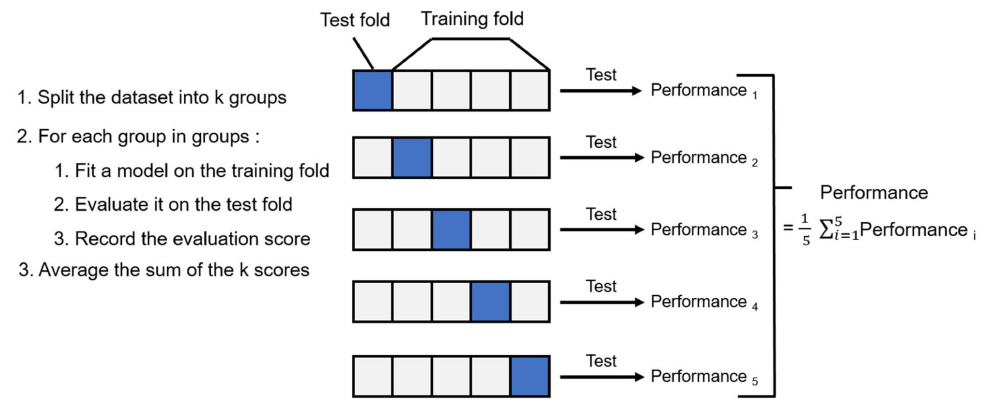
Figure 10. k -Fold cross-validation. Table 4. Comparison of three models for five-fold